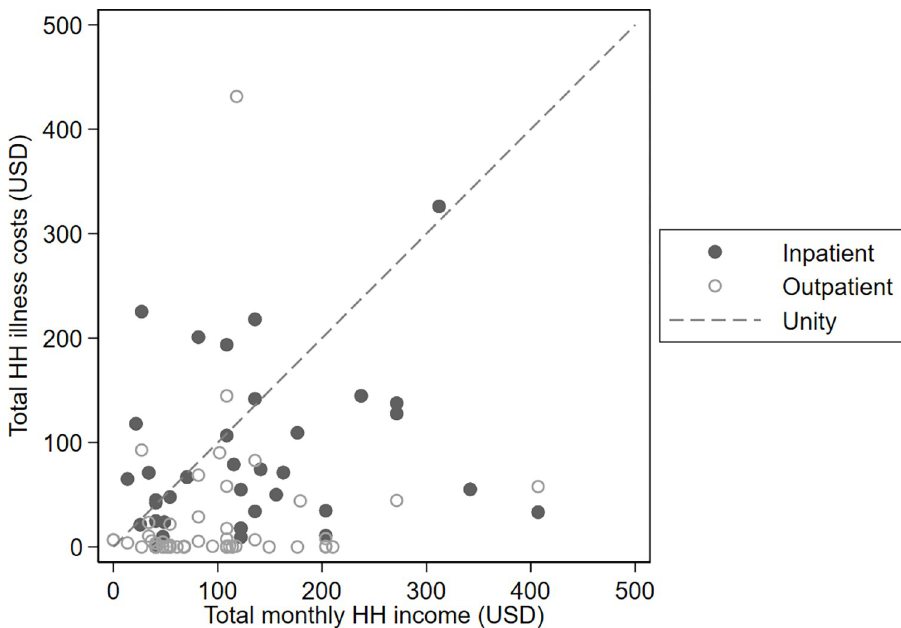
Fig 1. Total household illness costs vs total monthly household income in 2020 US dollars.